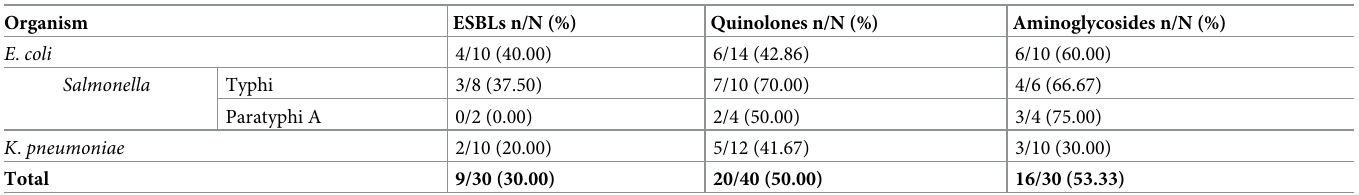
Table 4. Frequency of reduced susceptibility observed in susceptible isolates. Organism